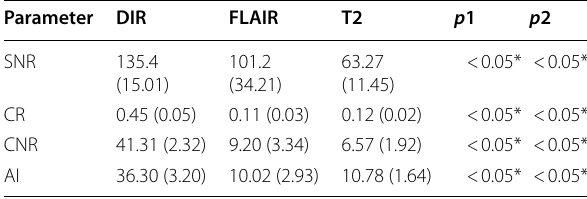
p : p value for F test (ANOVA) with repeated measures for comparing between different period Significance between periods was done using Post Hoc Test (adjusted